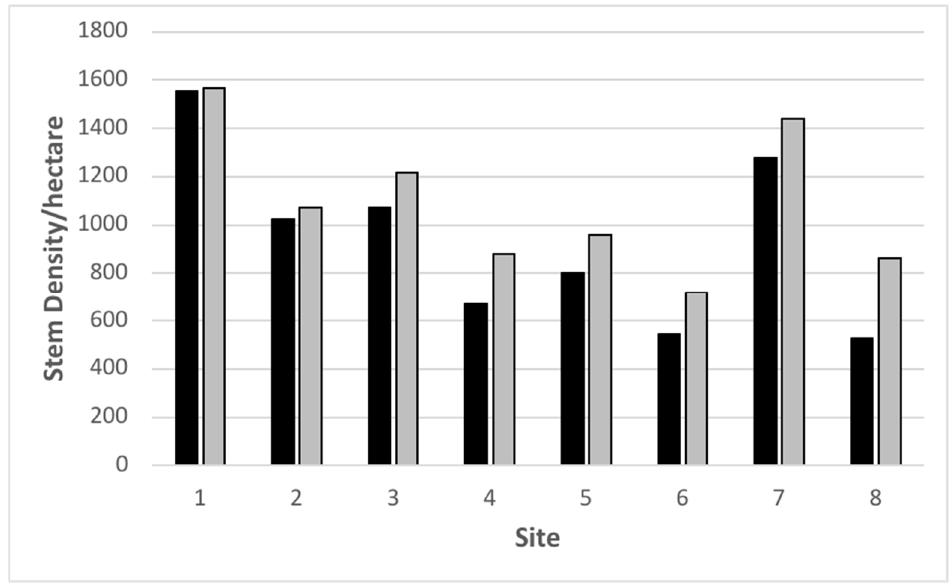
Figure 4. Overall stem density for Stations A (black) and B (gray) at Sites 1–8 in 2017.